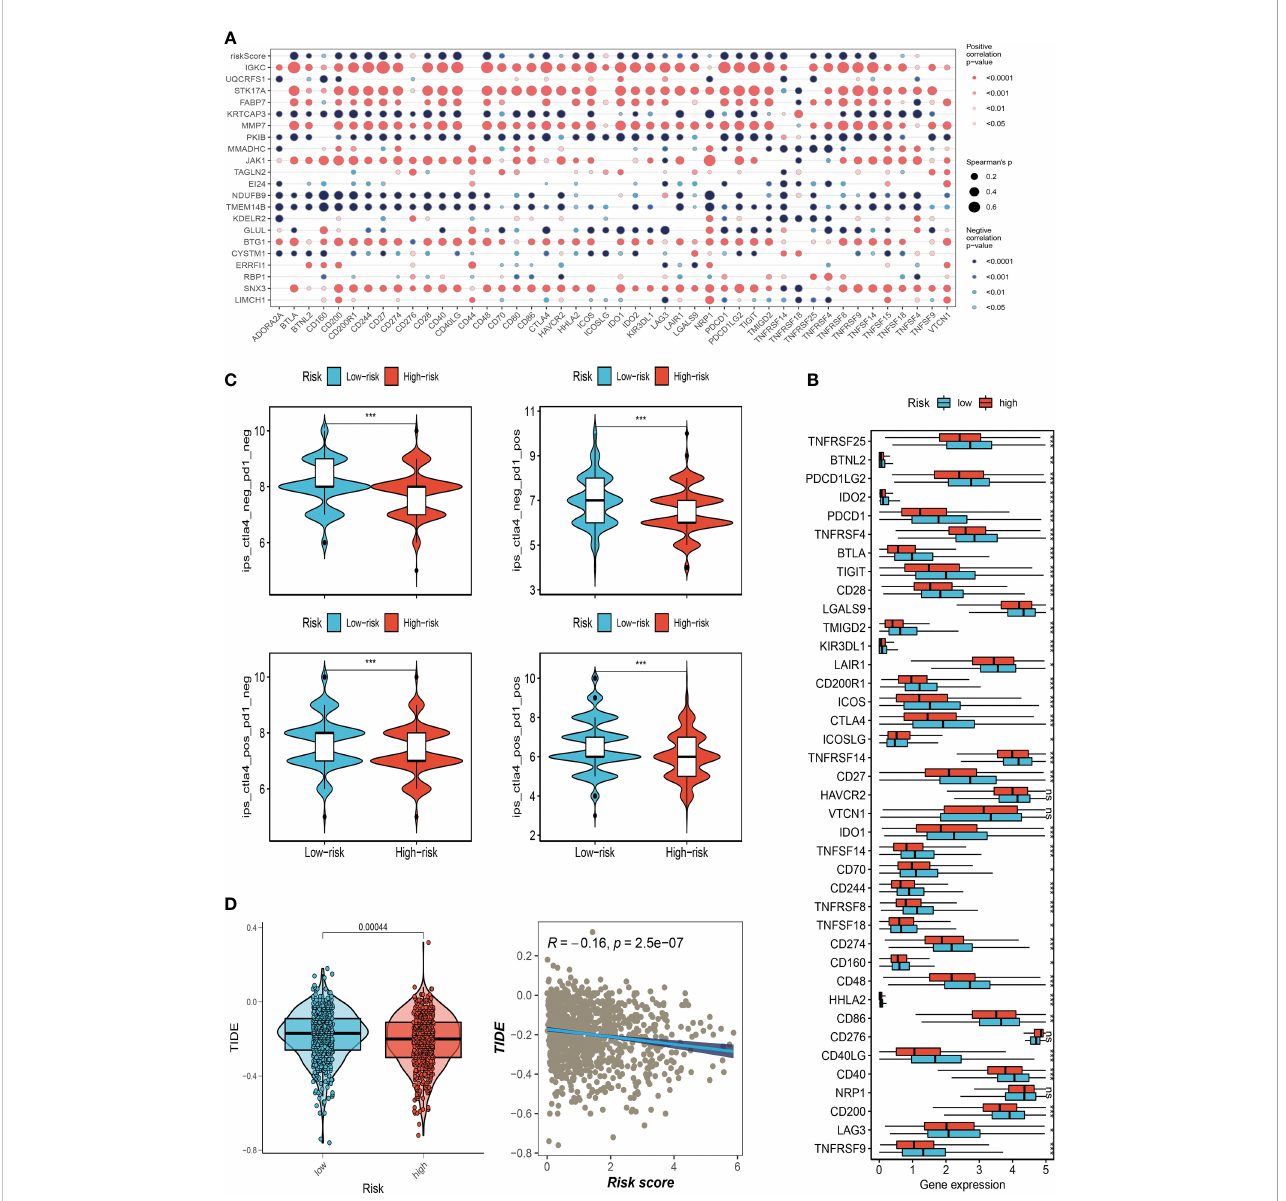
FIGURE 8 Correlation analysis of immune-checkpoint and treatment response. (A) Correlation between model gene and immune checkpoint. (B) Differences in the abundance of immune-checkpoint-related genes between high and low-risk groups. (C) Differences in IPS reactivity between high and low-risk groups. (D) The difference in TIDE scores between high and low-risk groups. (*P<0.05, **P<0.01, ***P<0.001). The ns indicates No signi fi